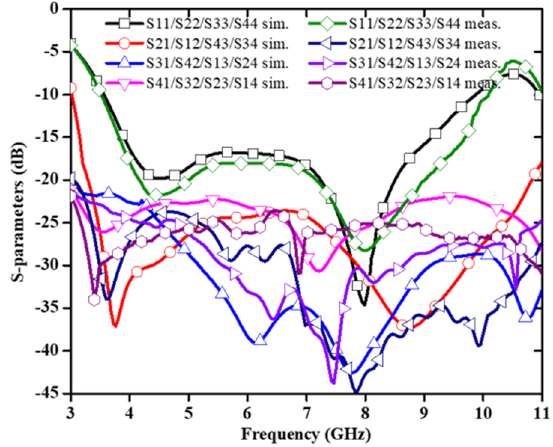
Figure 6. S − parameters of the designed antenna [22].